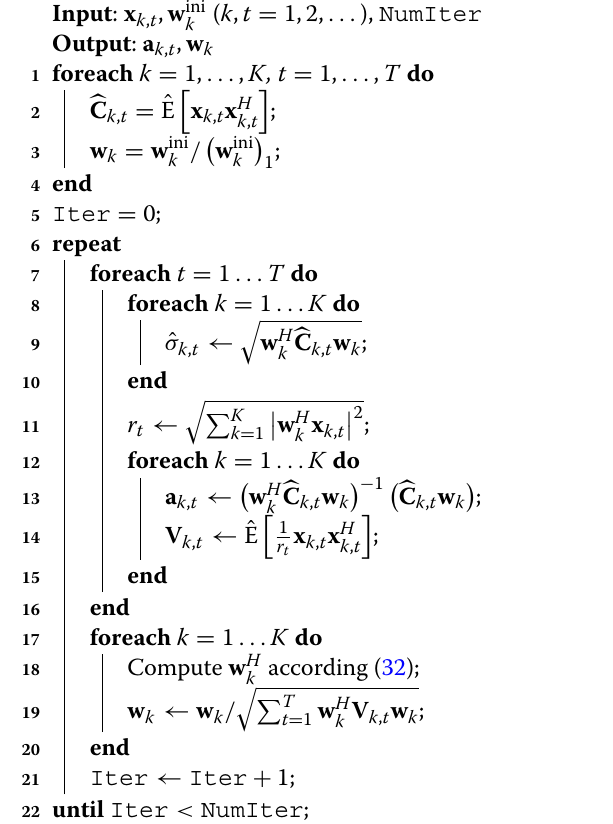
Algorithm 1: Pseudo-code of